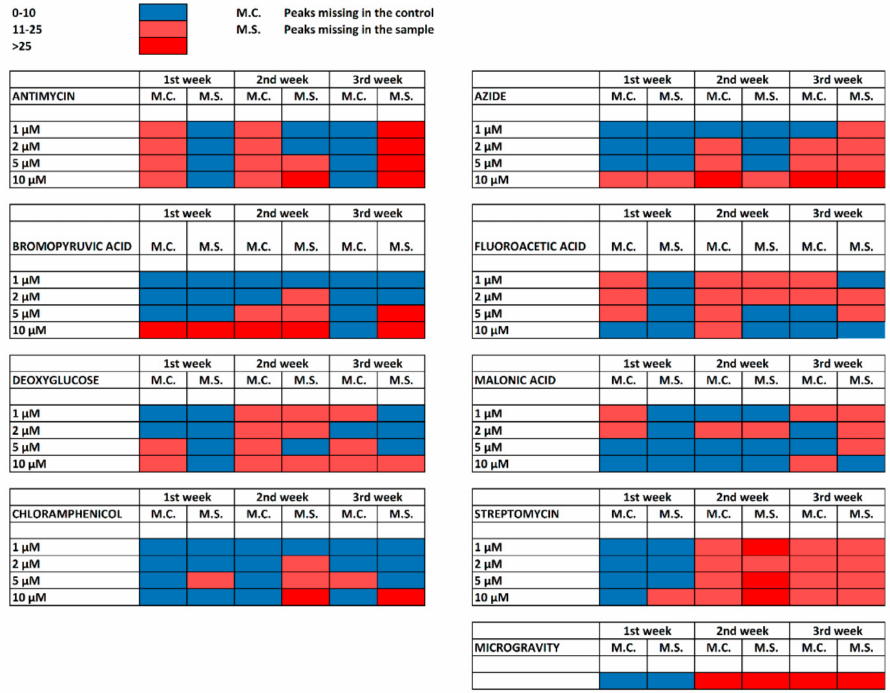
Figure 2. Heat maps with peak differences in the intact cell matrix-assisted laser desorp- tion/ionization time-of-flight mass spectrometry (IC MALDI-TOF) mass spectra for all treatments and incubation